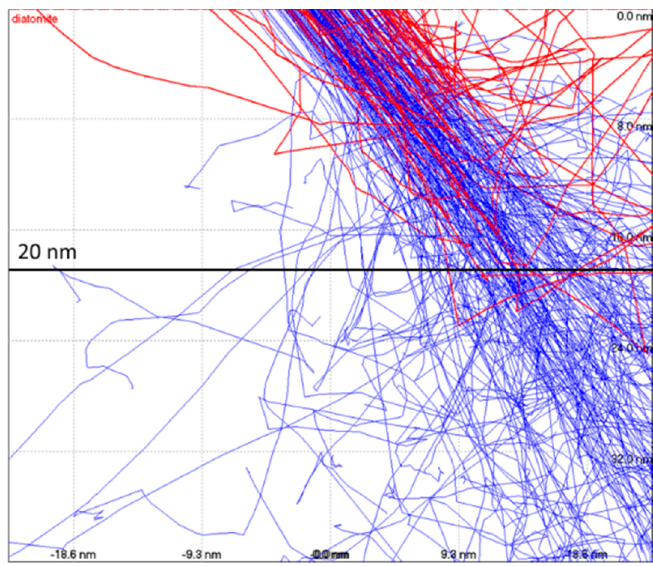
Figure 6. Trajectories of electrons into a silica-based material, diatomite, simulated by the Monte Carlo method in the Casino software (http://www.gel.usherbrooke.ca/casino/index.html) [66]. Acceleration voltage of the electron beam is 2 kV, incident angle is 38°, and dose is 10 5 . Blue tracks represent incident electrons, whereas red tracks represent backscattered electrons.